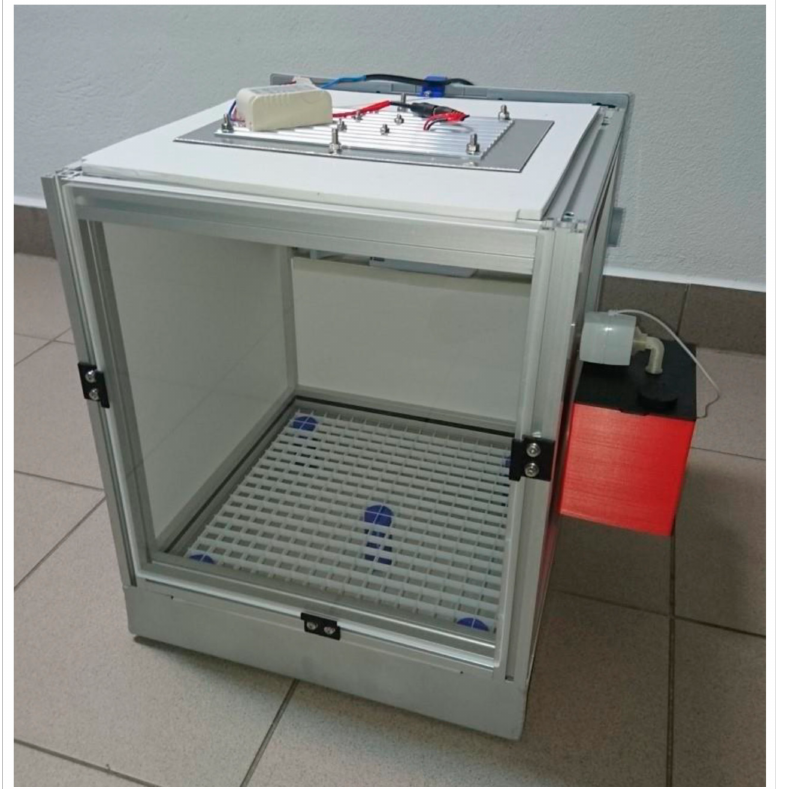
Figure 5. Fully assembled environmental